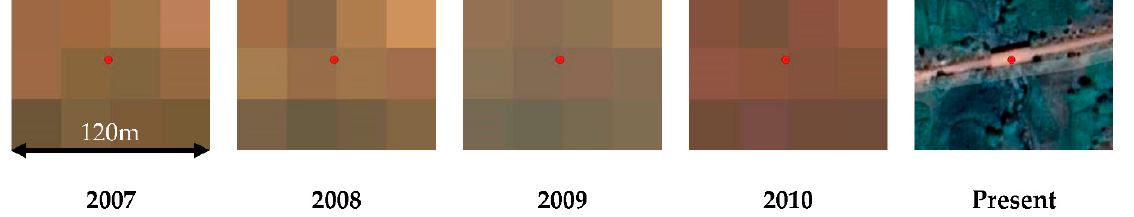
Figure 27. Satellite images of Otaki bridge from which the year of construction cannot be judged.